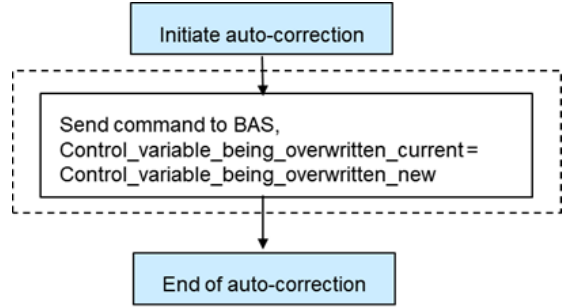
Figure 2. Flow chart of the general auto-correction process.